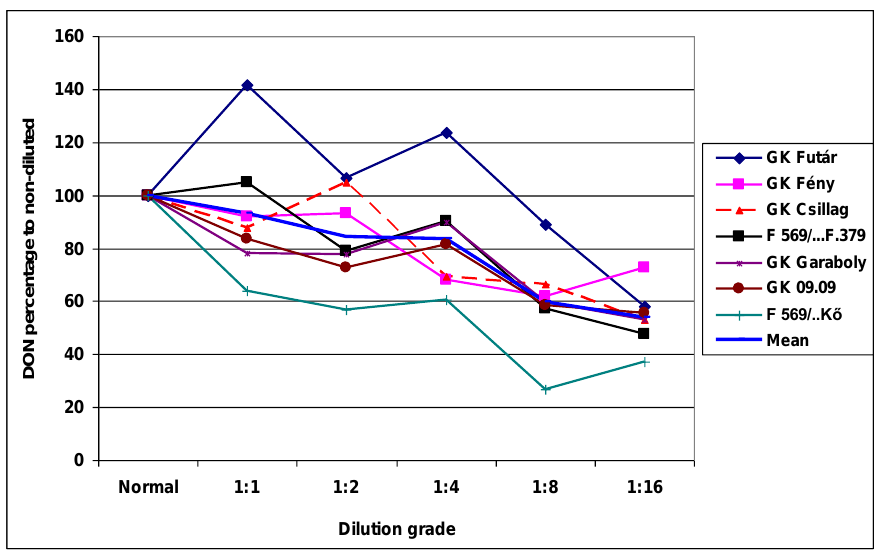
Table 9. The resistance of wheat genotypes against different Fusarium isolates expressed in DI, FDK and DON responses, 2013 – 2014. ( A ) Disease Index and Isolates %. ( B ) FDK and Isolates %. ( C ) DON and Isolates mg/kg. ( D ) Correlations between traits separately for all isolates.